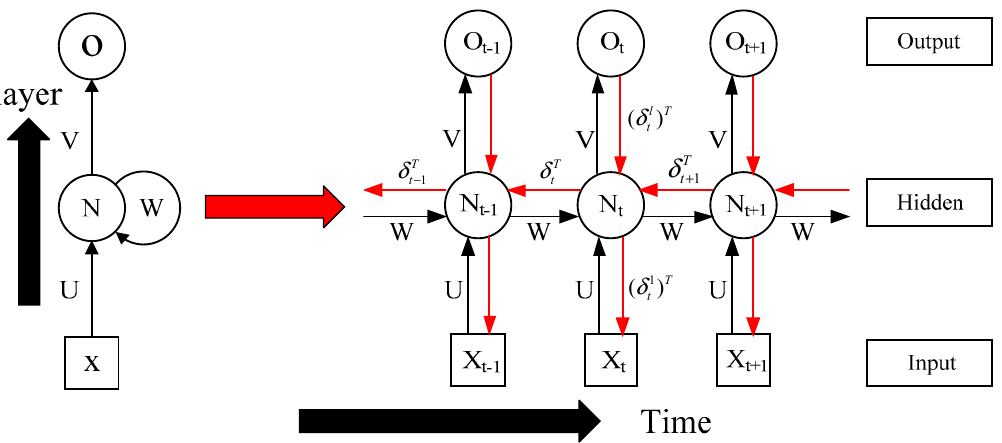
Figure 2. Basic structure and operating scheme of a recurrent neural network (RNN).